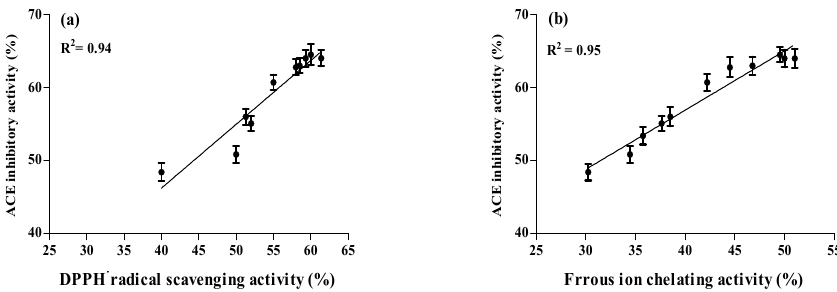
Figure 7. Correlation between bioactivities (%) of A. lecanora alcalase hydrolysates. ( a ) ACE inhibition versus DPPH radical scavenging activity; ( b ) ACE inhibition versus metal ion chelating activity. R 2 values indicated the best-fit linearity functions. Bars represent standard deviations from triplicate determinations.